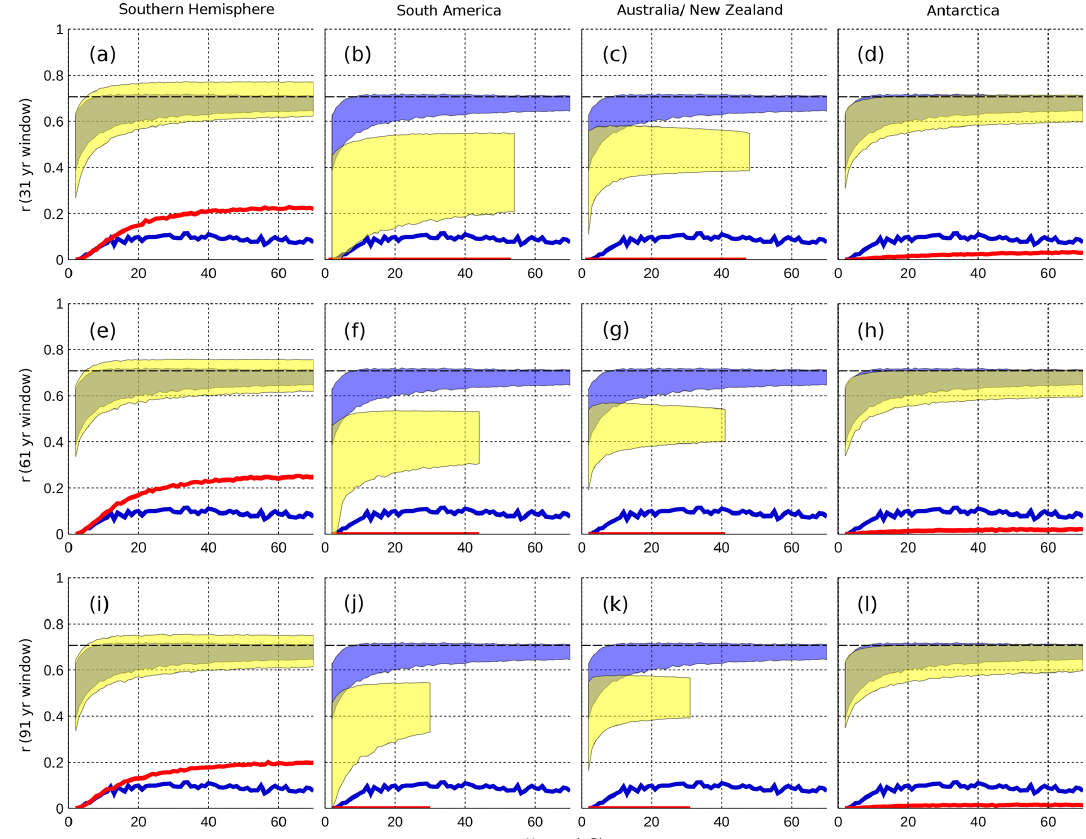
Figure 4. Differing reconstruction skill achieved when using SAT-derived proxies sourced from the entire Southern Hemisphere (a, e, i) , South America (b, f, j) , Australia and New Zealand (c, g, k) , and Antarctica (d, h, l) only. The correlation between a SAT-derived reconstruction and the SAM is plotted on the y axis, while the number of sites used ( n = 2 : 70) in a reconstruction is plotted on the x axis. Shaded regions represent the range between the minimum of the 5th percentile and the maximum of the 95th percentile for each network size across 10000 reconstructions (described in Sect. 2.3). Each set of regional reconstructions is shaded in yellow, and the end of this yellow region indicates the number of samples available when it is below 70. Each panel also includes the range in skill for reconstructions with sites sourced from the entire Southern Hemisphere and calibrated with a “true” 500 year window (blue shading). The blue line indicates the percentage of true SH reconstructions that meet or exceed our skill threshold of being able to explain 50% or more of the variability in the SAM. The red line indicates the same thing, but for each regional reconstruction. The dashed black line indicates the r value required to meet our skill